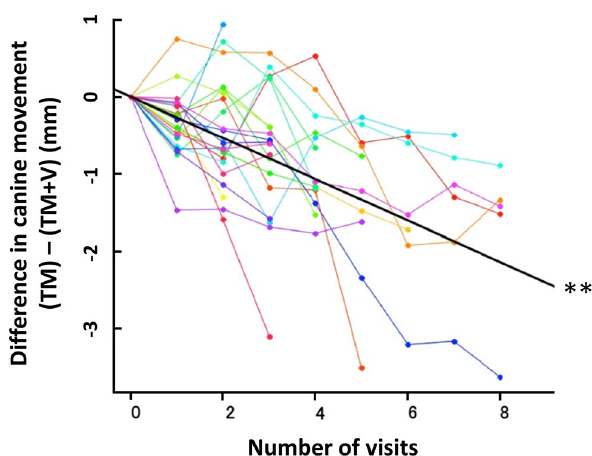
Figure 3. The evaluation of canine movement by LME model. The LME model of the amount of canine movement for each visit. Each colored line represents the difference in the amount of canine movement between the TM and TM + V group of subjects at each number of visits. The result of the fixed effect incorporated in each subject as a random effect is shown as a black line. The slope of the black line was -0.26, indicating a significant movement in the model. **P < 0.01.